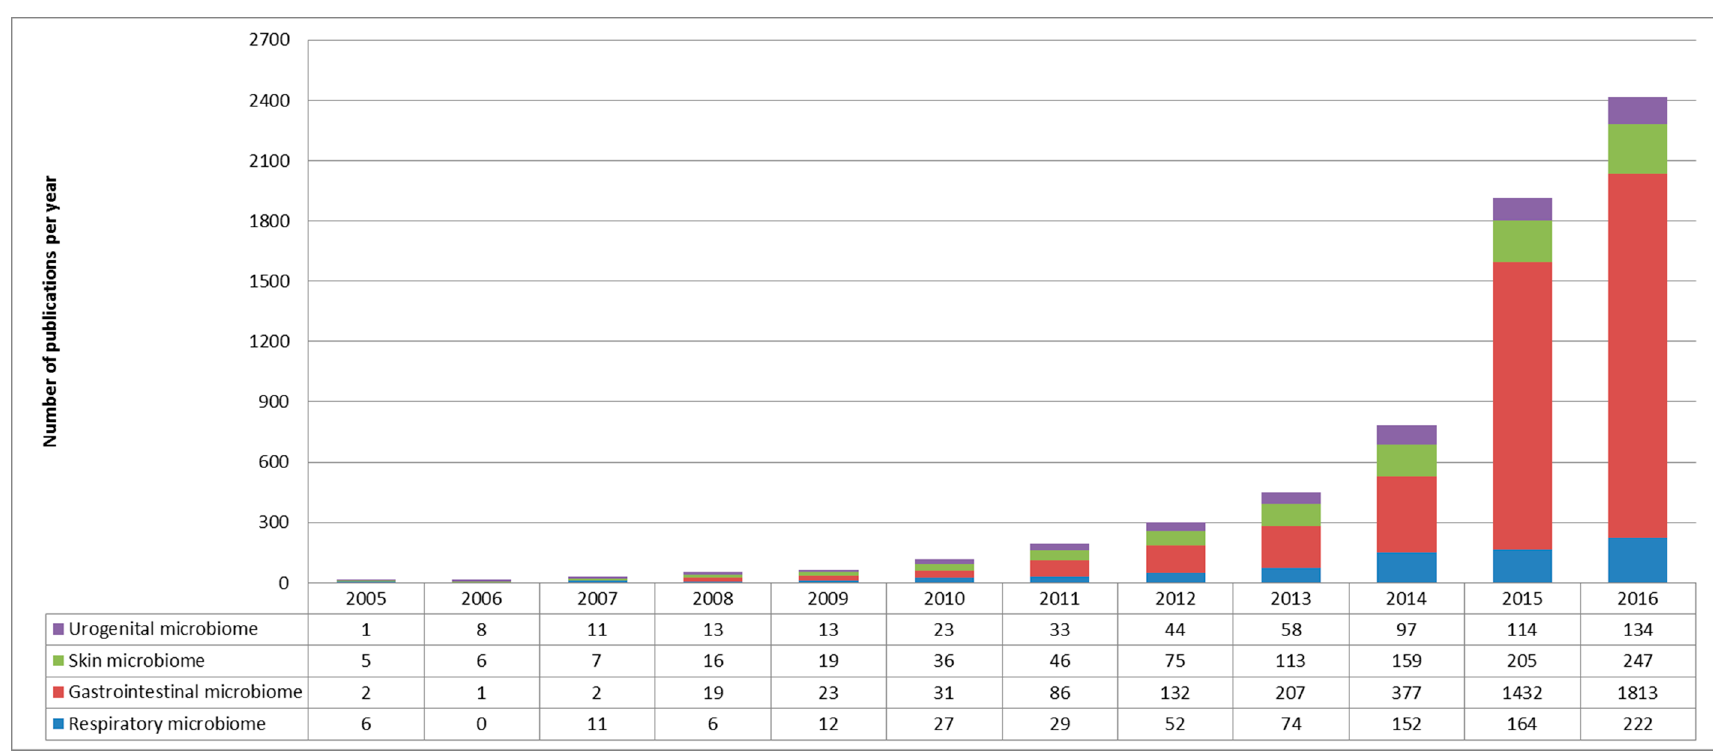
Figure 1 . Bibliometric parameters of microbiome studies. Representations were limited to the four most abundant microbiomes (urogenital tract in purple, skin microbiome in green, gastrointestinal tract in red and respiratory microbiome in blue). The number of publication focusing on microbiome increased slightly until 2011, after which Next Generation Sequencing (NGS) technologies became more widely available. Microbiome publications focused mainly on gastrointestinal microbiome; the other three niches being studied in the same proportions.